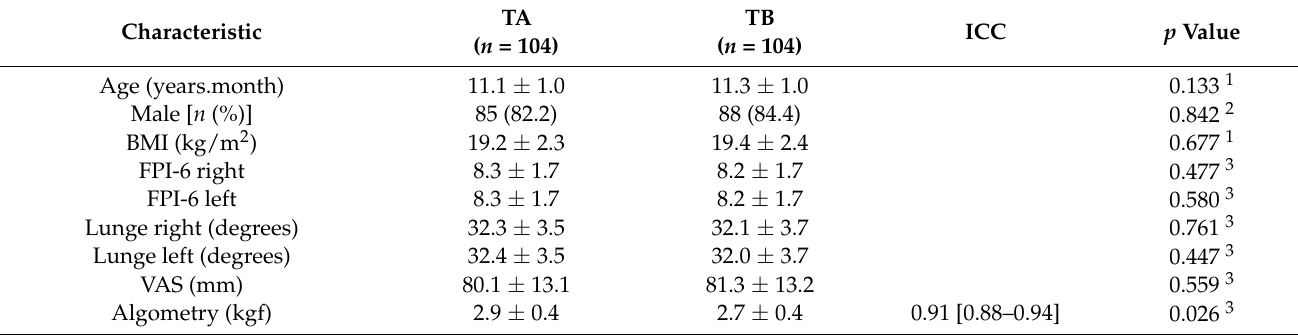
Table 1. Baseline characteristics of the children with calcaneal apophysitis.